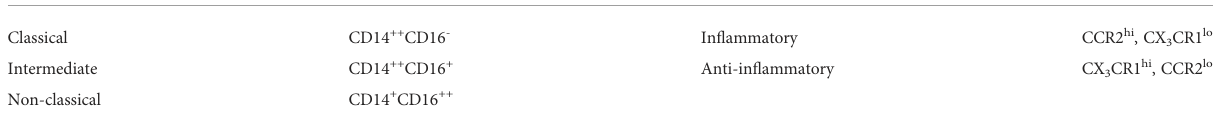
TABLE 1 Monocyte